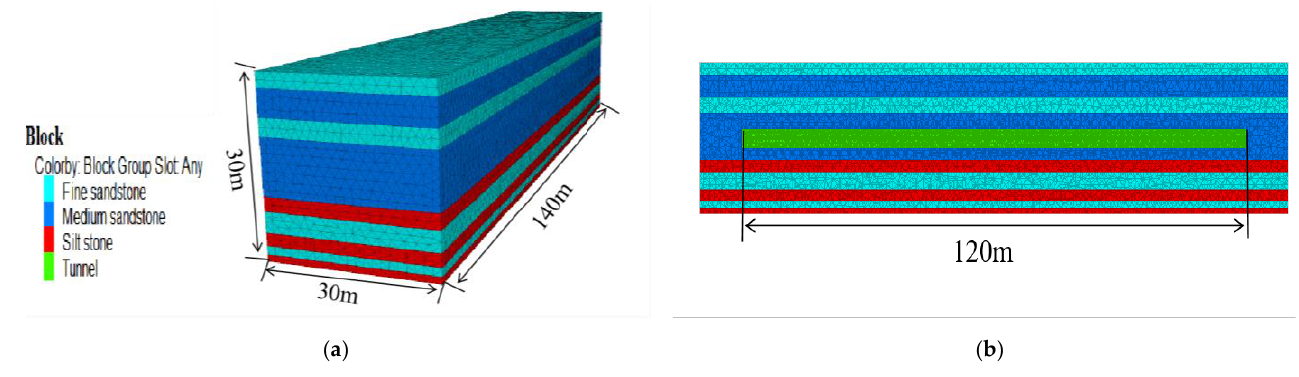
Figure 2. 3D numerical model: ( a ) whole model and ( b ) profile view. Table 1. Physical and mechanical parameters of the different lithologies.